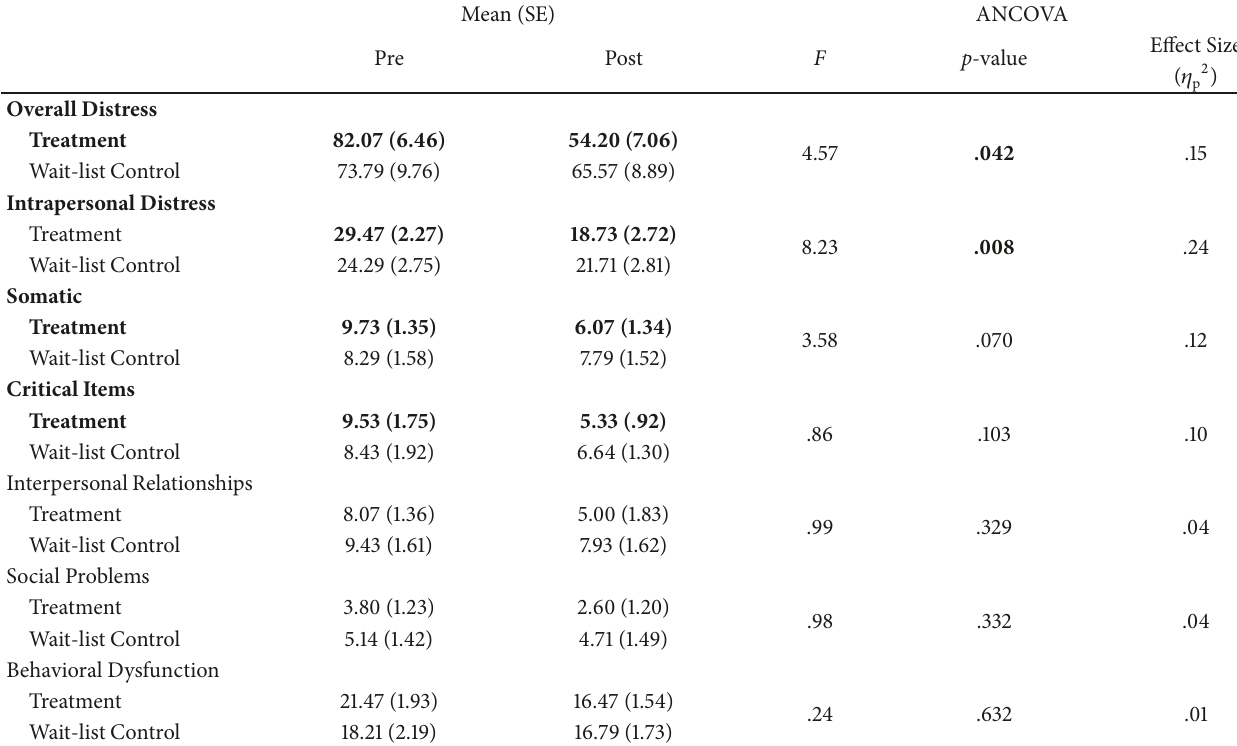
Table 3: Summary of relevant descriptive information, ANCOVA statistics, and effect sizes for parent-reported outcomes on the